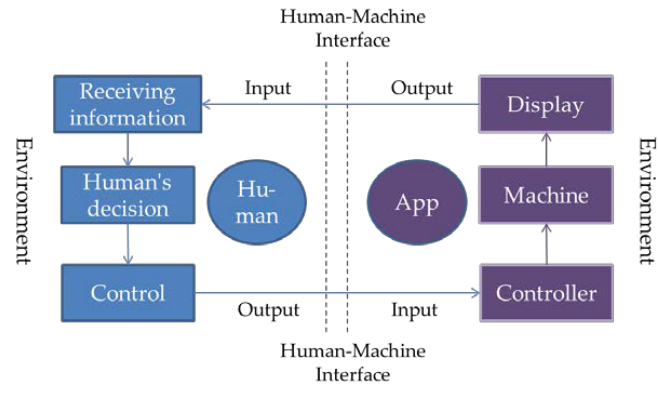
Figure 4. Human–machine interaction model.